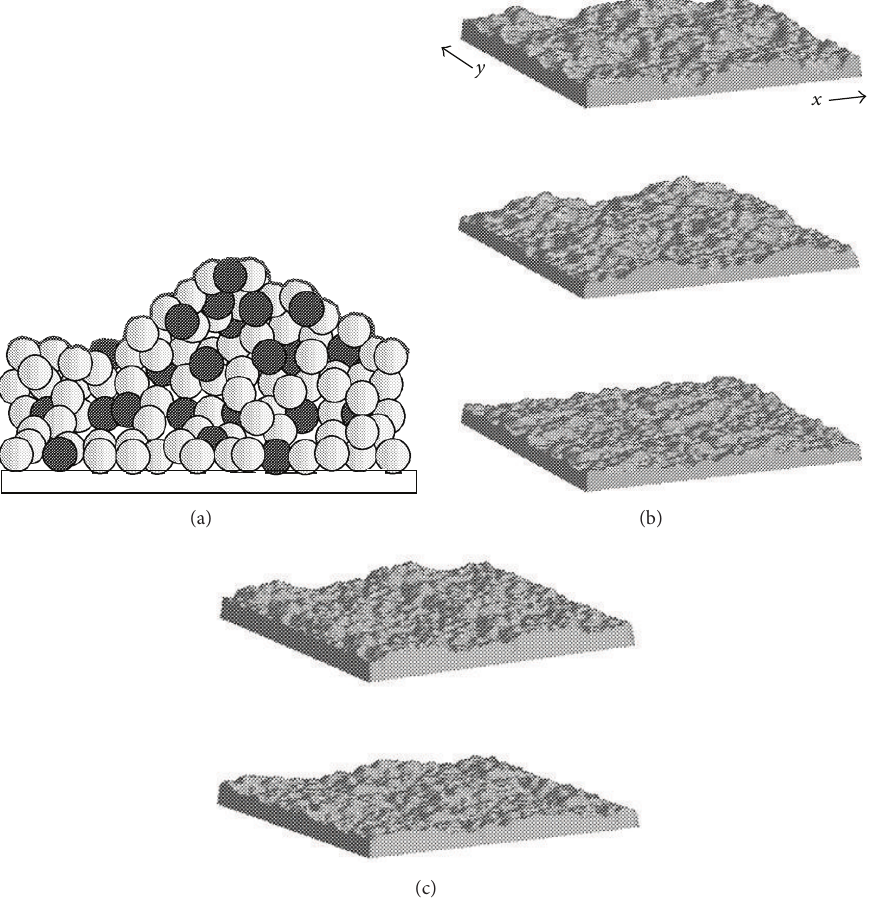
Figure 18: Morphology of PFPE films from MD simulations: (a) schematic of simulated surface roughness for (b) molecular weight dependence ( 𝑁 𝑝 = 10 (upper), 15 (middle), and 20 (bottom)) and (c) endbead functionality dependence ( 𝜀 𝑝 𝑤 = 𝜀 𝑝 = 1 (upper) and 𝜀 𝑝 𝑤 = 𝜀 𝑝 = 4